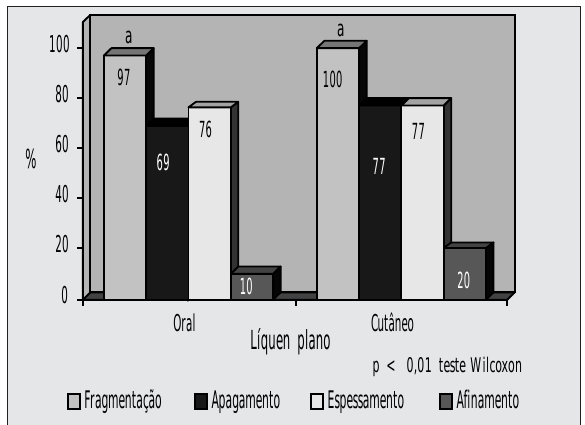
Figura 14 – Avaliação da membrana basal em 59 biópsias de líquen plano cutâneo e